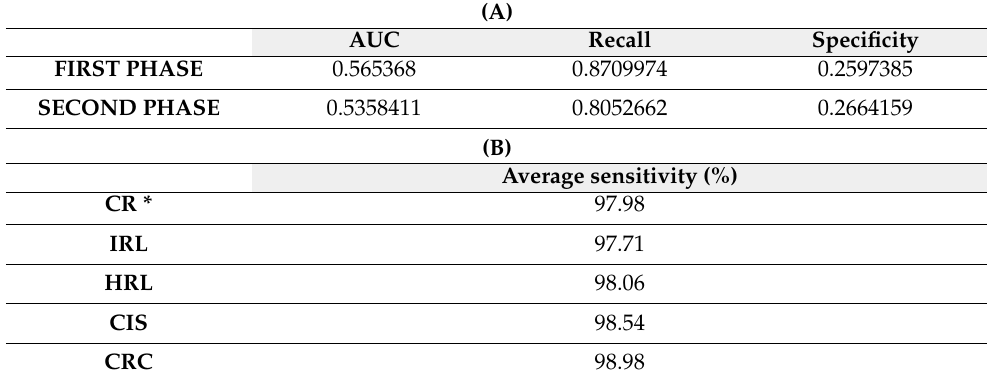
Table 1. Performance of the two-phase machine learning predictor. The reported values are mean values obtained from the 100 random splits and include a panel of four taxa for each of the phases plus sex, age and FIT-value. Samples with missing metadata were discarded from this analysis (n = 2817). (A) Average of area under the curve (AUC), recall and specificity for each of the phases. (B) Average sensitivity for clinically relevant samples and for each of the diagnoses included in this group.